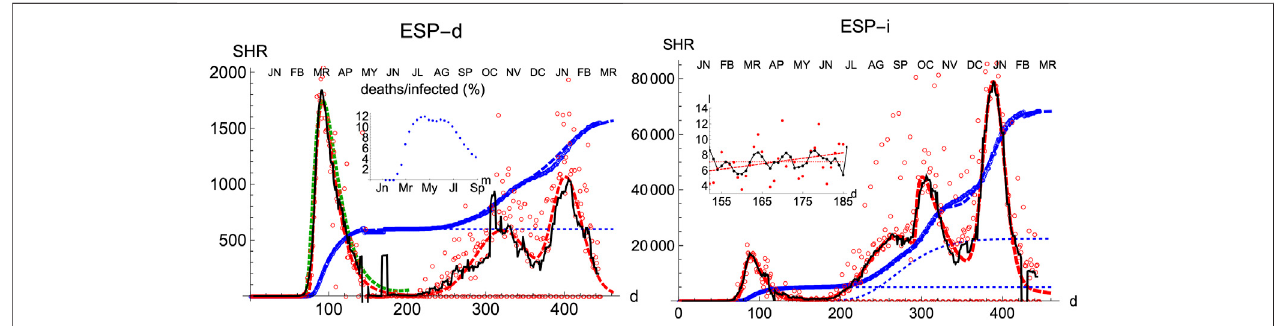
FIGURE 1 | SHR/Spain. Left/Right panels: deaths/infections related to COVID-19. Data (circles) are taken from Roser et al. (2021); Dong et al. (2020). Dashed curves fi tthedatausing Eqs1 , 2 .Blue:totalaccumulatedcasespermillioninhabitant.Red:dailycasesperonehundredmillioninhabitants(thefactor × 100isintroduced forthesakeofbettervisibilityonthescaleoftotalcasesonly).Theblackthinlineisa7 daysmovingaverageofdata.Thegreendashedlineistheaveragedrepresentative curve discussed in section sct:averaged. Red and blue thin dotted lines give the contributions of individual waves. The inset (left) gives the percentage between deaths and infections from March to September. The inset (right) enlarges region II where a nearly constant number of infections takes place (red: least-squares fi t to data and constant mean value. Black: 7 days moving average). Changes in data collection methodology took place on April 19th, April 25th and November 4th, producing discontinuities on the